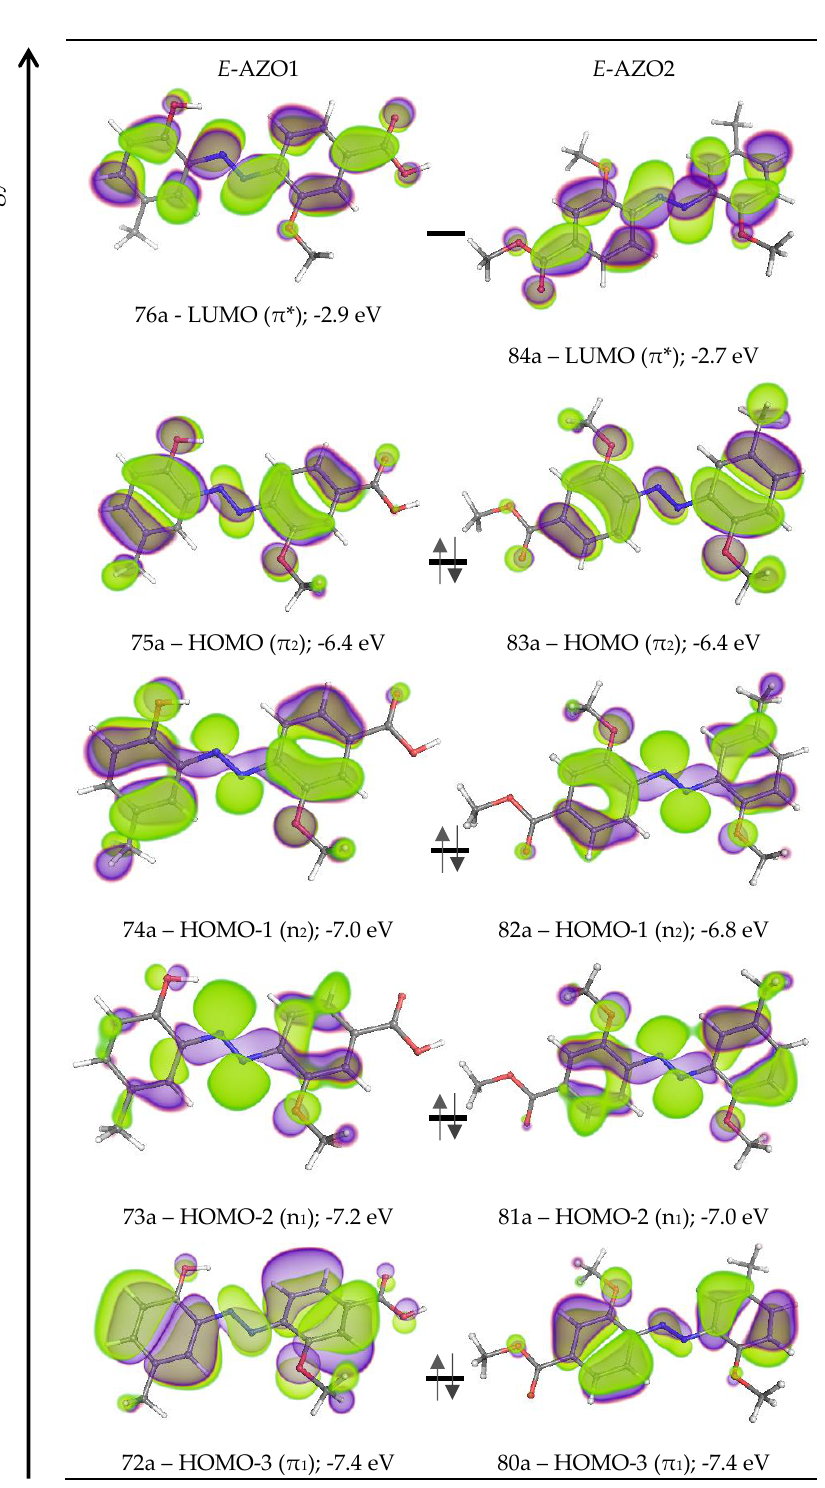
Figure 4. Kohn-Sham molecular orbitals relevant to the electronic transitions of E -AZO1 and E -AZO2 in the visible region.